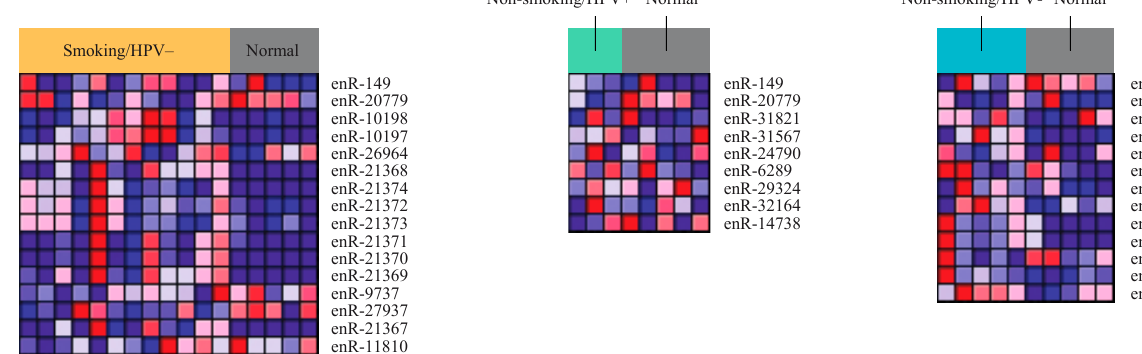
Figure 8. Heatmaps, each displaying the top overlapping (TCGA and GEO datasets) differentially expressed eRNA between the patient cohort and normal samples. Blue represents a low expression of eRNA, and red represents a high expression. Differentially expressed eRNAs were considered significant if they had a p -value < 0.05 and |log (FC)| > 1.